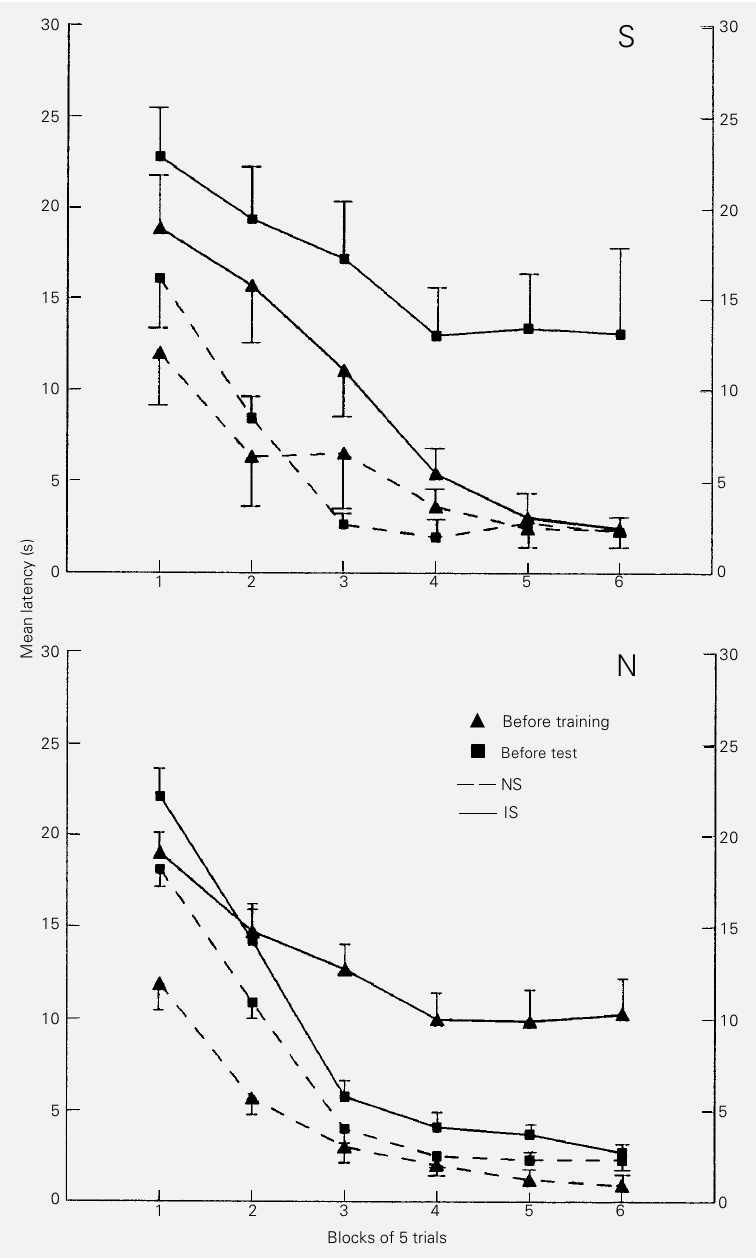
Figure 1 - Naltrexone reverses learned helplessness when administered before the test session. Data are reported as the mean escape latency (s) – SEM for blocks of 5 trials for 6- 17 rats in each group. The rats received either saline (0.9%, S) or naltrexone (8 mg/kg, N) before the training or test session and were given either inescapable (IS) or no shocks (NS) in a shuttle